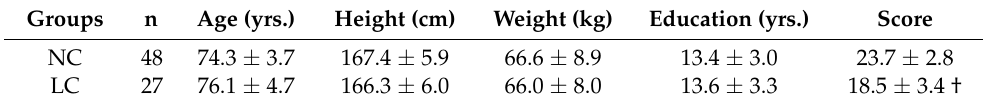
Table 1. Demographics and K-MoCA score of the two groups.